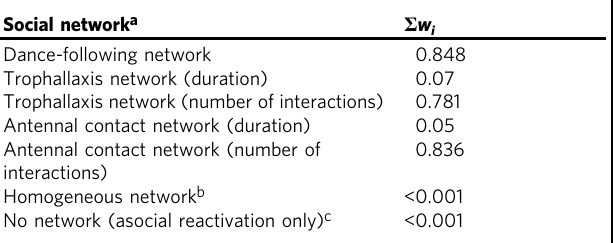
Table 4 Support ( Σ w i ) for social transmission pathways in the FULL feeder reactivation NBDA.